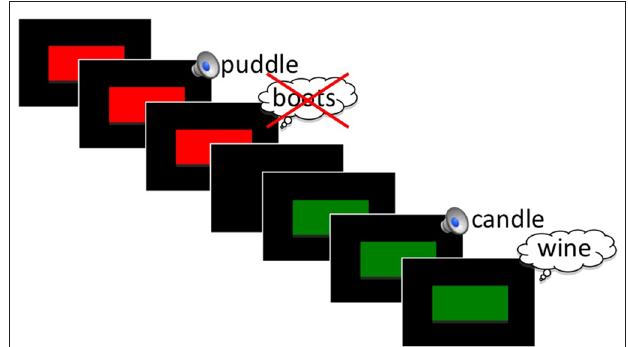
FIGURE 1 | Schematic of the Think/No-Think (TNT) phase of the experiment for an example No-Think (red) and Think (green) trial. See text for stimulus